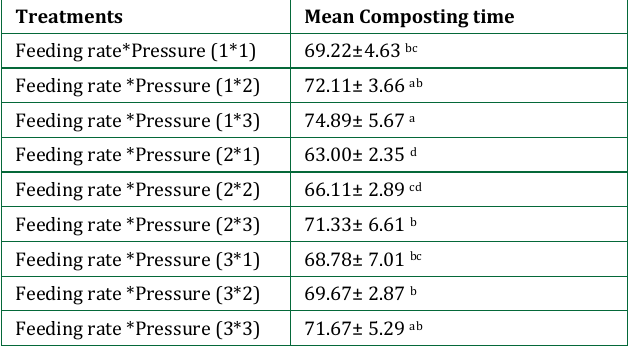
Table 4: Combine effect of feeding rate * pressure on composting